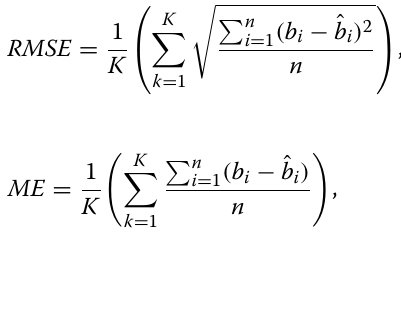
Table 7 Summary of the items with linear position effects in the simulation study Position in form 1